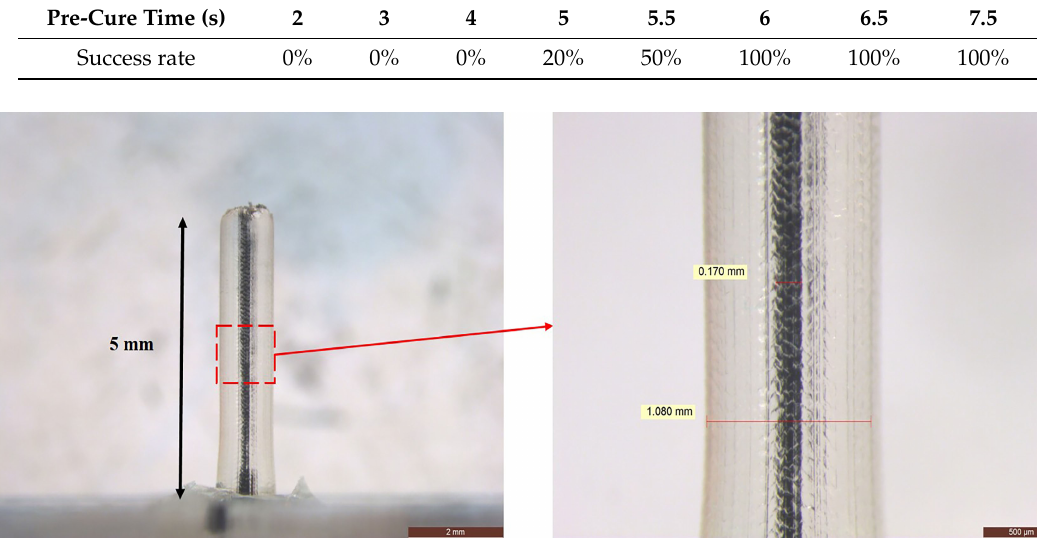
Table 4. Success rate of uniform-shaped hollow connectors printing (n = 10).